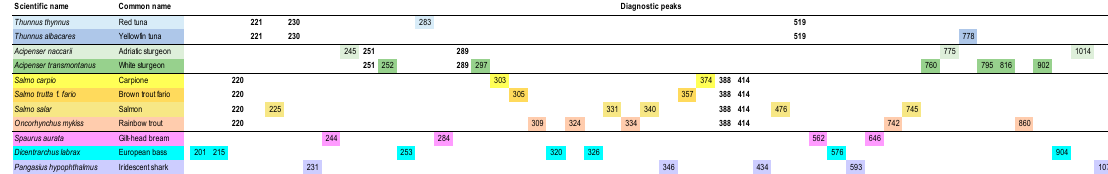
Figure 3. Meat-filling authentication in a sample of tortellini bought in the market. The TBP profile found in tortellini is compared with the pork and beef reference profiles. Numbers in the electropherograms refer to the length of the TBP-amplified fragment (peak size).